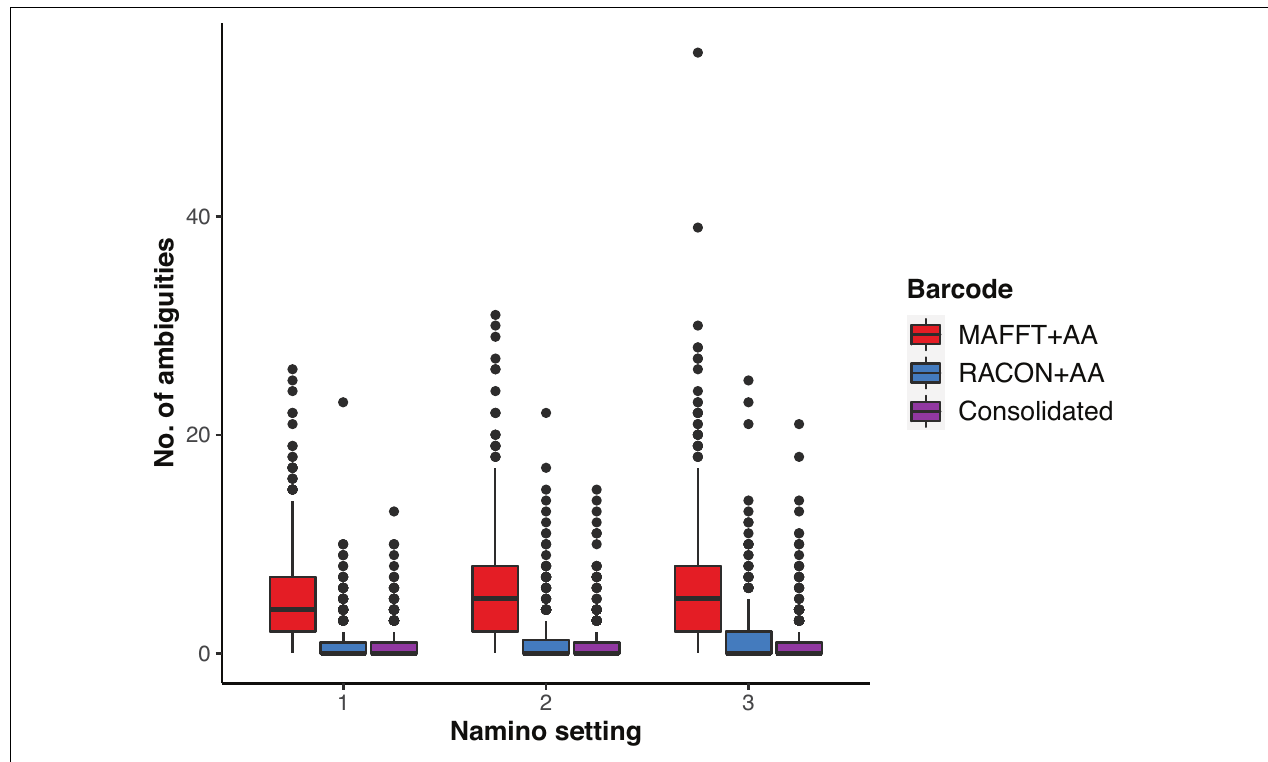
FIGURE 3 | Ambiguities remaining in the three types of error-corrected MinION barcodes: MAFFTT+AA (red), RACON+AA (blue), and consolidated (purple) across varying namino settings (1–3).